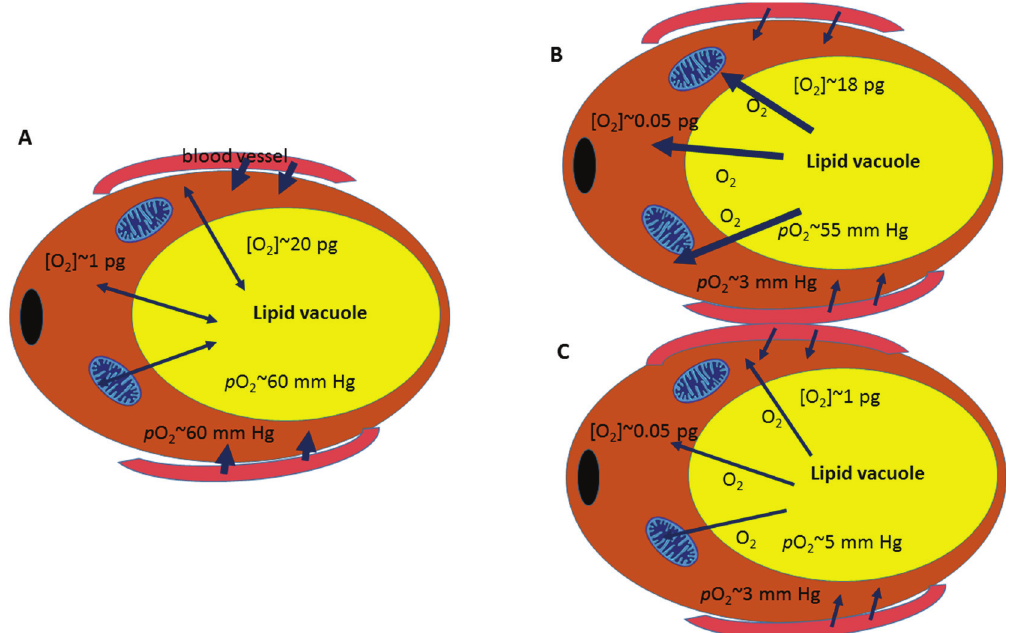
Figure 1. Schematic of oxygen transport in adipocytes: ( A ) Equilibrium oxygen saturation: during long-term exposure at sea level, no net flux of O 2 occurs between the cytosolic and the lipid compartment of the cell as both compartments are in equilibrium due to saturation with O 2 . ( B ) Acute Hypoxia: during acute hypoxia, the p O 2 in the cytoplasm drops whereas the p O 2